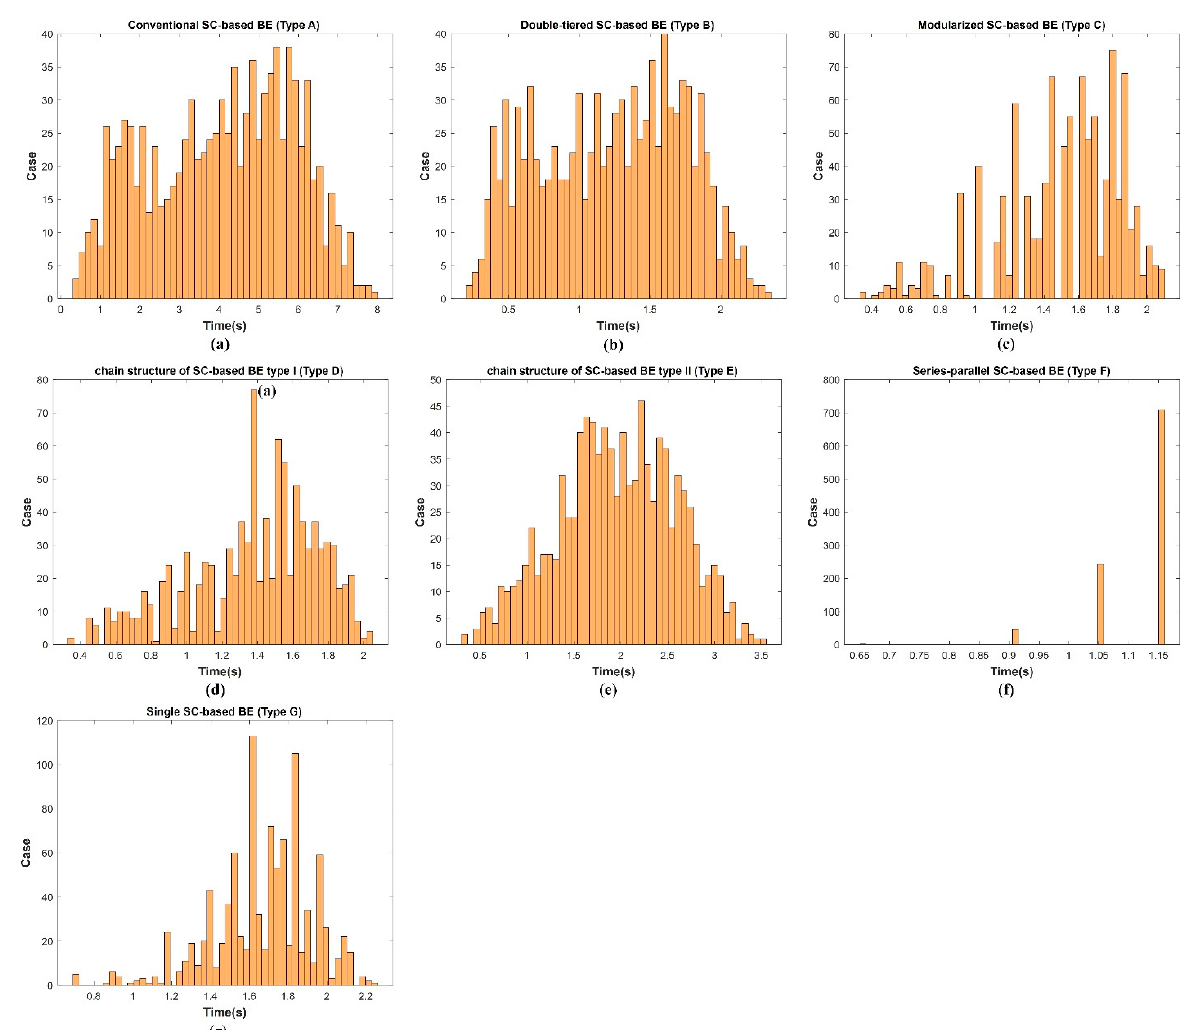
Figure 19. Histogram of the balancing times for the first 1000 cases (case 1) for 8 battery cells: ( a ) type A; ( b ) type B; ( c ) type C; ( d ) type D; ( e ) type E; ( f ) type F; ( g ) type G.